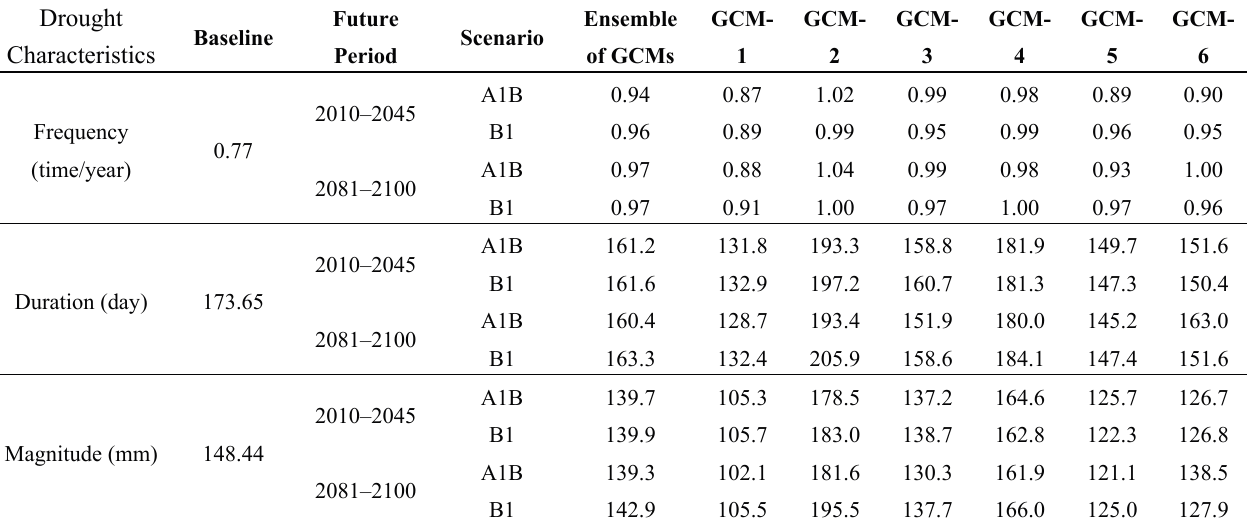
Table 3. Impact of climate change on streamflow drought